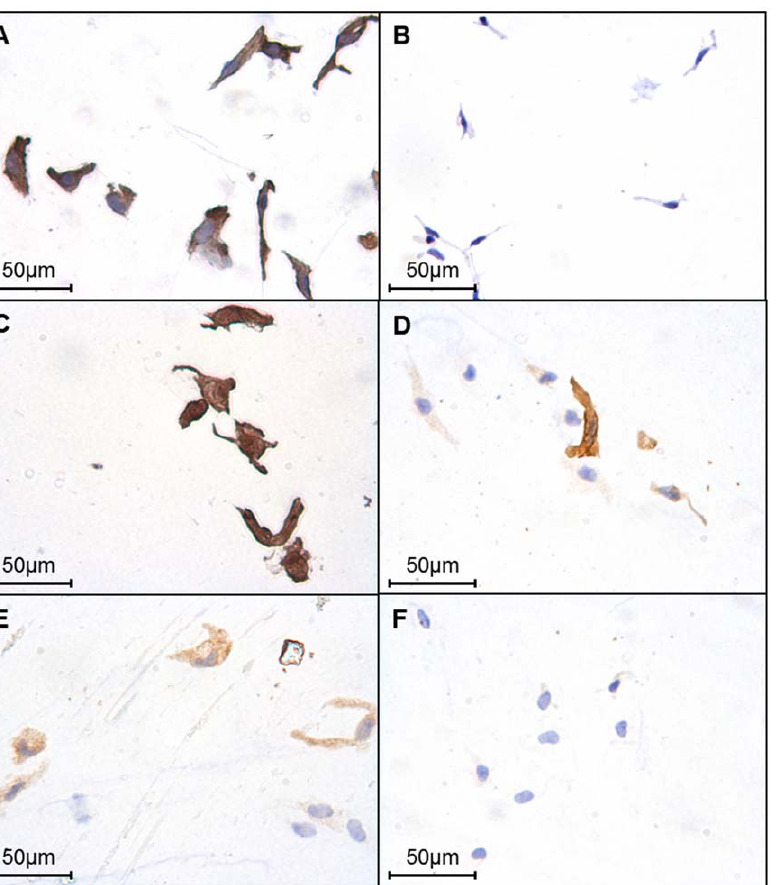
Figure 1. Phenotype characterisation of isolated CPASMCs. Representative examples of immunocytochemistry ( A ) a -smooth muscle actin ( a - SMA), ( B ) CD31, ( C ) myosin heavy chain-2 (MHC-2), ( D ) h-caldesmon, ( E ) non-muscle myosin heavy chain-B (NMMHC-B), and ( F ) negative control; non-immune IgG. Positive immunostaining (DAB; brown) and nuclei (haematoxylin; blue).